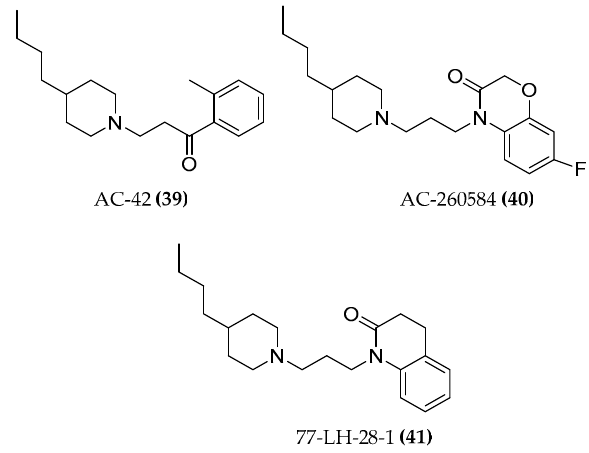
Figure 17. Structures of AC-42, AC-260584 and 77-LH-28-1.